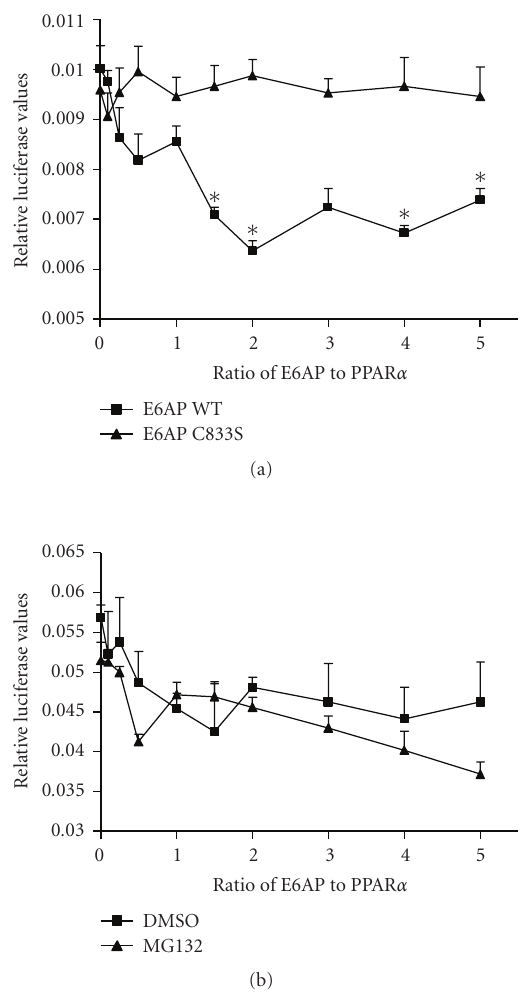
Figure 4: E3 ubiquitin ligase activity of E6-AP is required for regulating PPAR α transactivation. (a) 293T cells were transfected with plasmids expressing 4X-ACO-Luciferase, pRLCMV, PPAR α , E6-AP, or E6-AP-C833S that is defective in ubiquitin ligase function. (b) Cells were treated with 0.1% DMSO or 5 μ M MG132 for 6 hours. Cells were lysed and luciferase activity was corrected for transfection e ffi ciency and protein. Asterisks indicate a significant di ff erence when compared to the corresponding 0 ratio group. ( ∗ P < . 05 with statistical analysis using ANOVA). The graph is representative of 3 independent